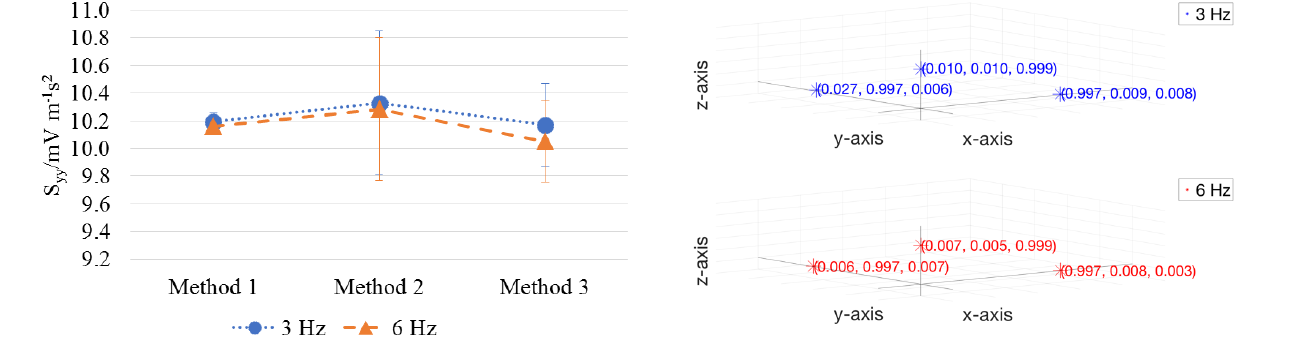
Figure 11. Piezo-electric accelerometer: comparison between methods (main sensitivity along the y axis, S yy ).